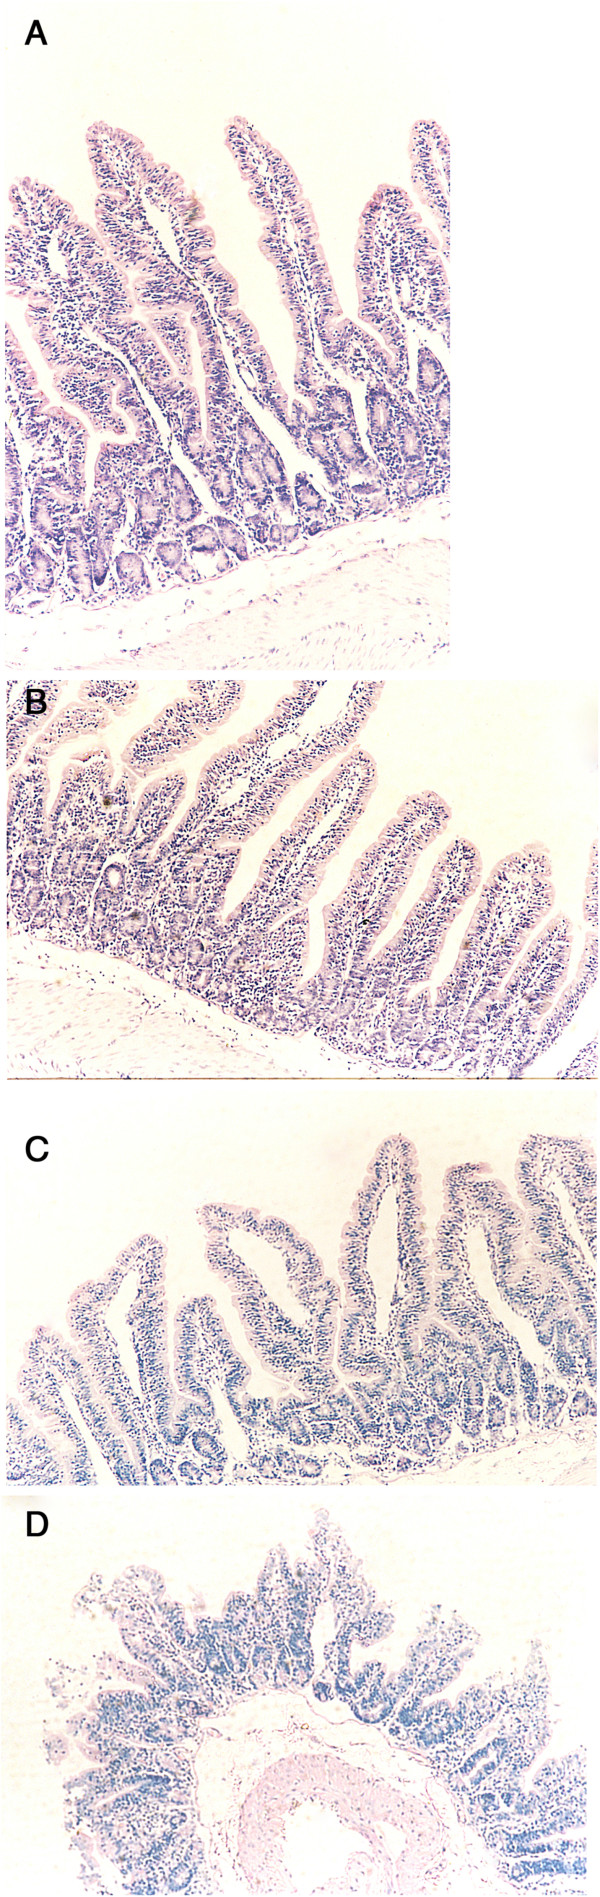
Pathological changes of intestinal mucosa observed by light microscopy. (A) Normal control; (B) after an intra-abdominal pressure (IAP) of 15 mmHg for 4 hrs, jejunal villi were moderately edematous, mild neutrophil infiltration can be seen, but gross integrity was relatively maintained; (C) after an IAP of 25 mmHg for 2 hrs, obvious neutrophil infiltration and central lacteal expansion were seen, along with thickening of the walls of the villi; (D) after an IAP of 25 mmHg for 4 hrs, extensive jejunal villi erosion and necrosis were seen. (Magnification for each: ×100).